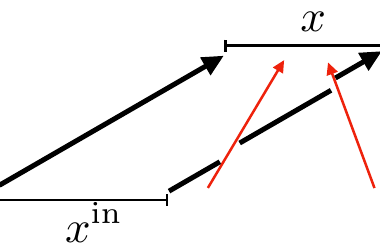
Figure 10: The change of metric due to interactions in integrable